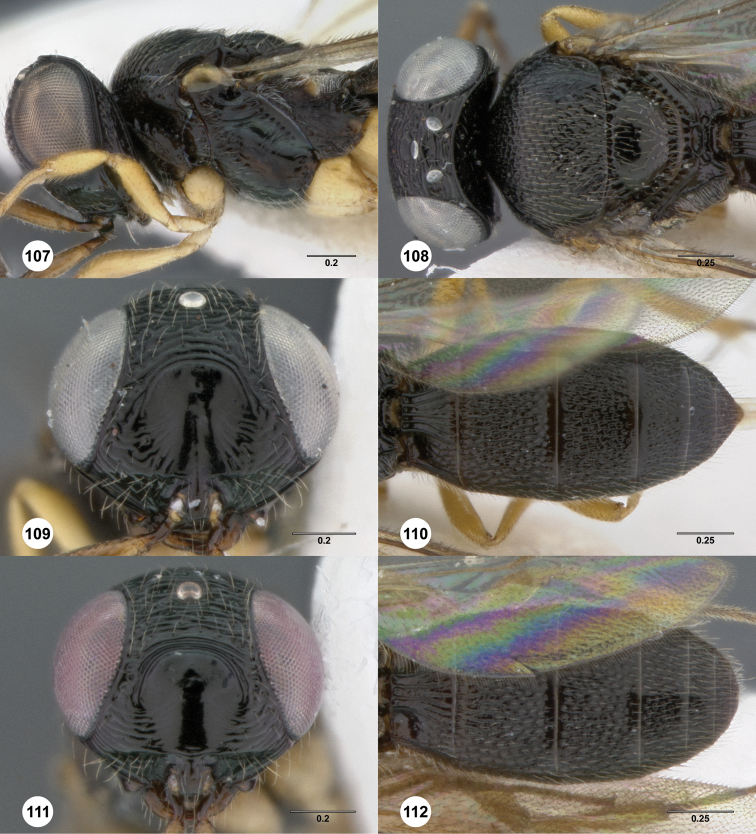
Oxyscelio fluctuum sp. n., paratype female (OSUC 148368) 107 Head and mesosoma, lateral view. Paratype female (OSUC 148365) 108 Head and mesosoma, dorsal view 109 Head, anterior view 110 Metasoma, dorsal view. Paratype male (OSUC 438977) 111 Head, anterior view 112 Metasoma, dorsal view. Morphbank48